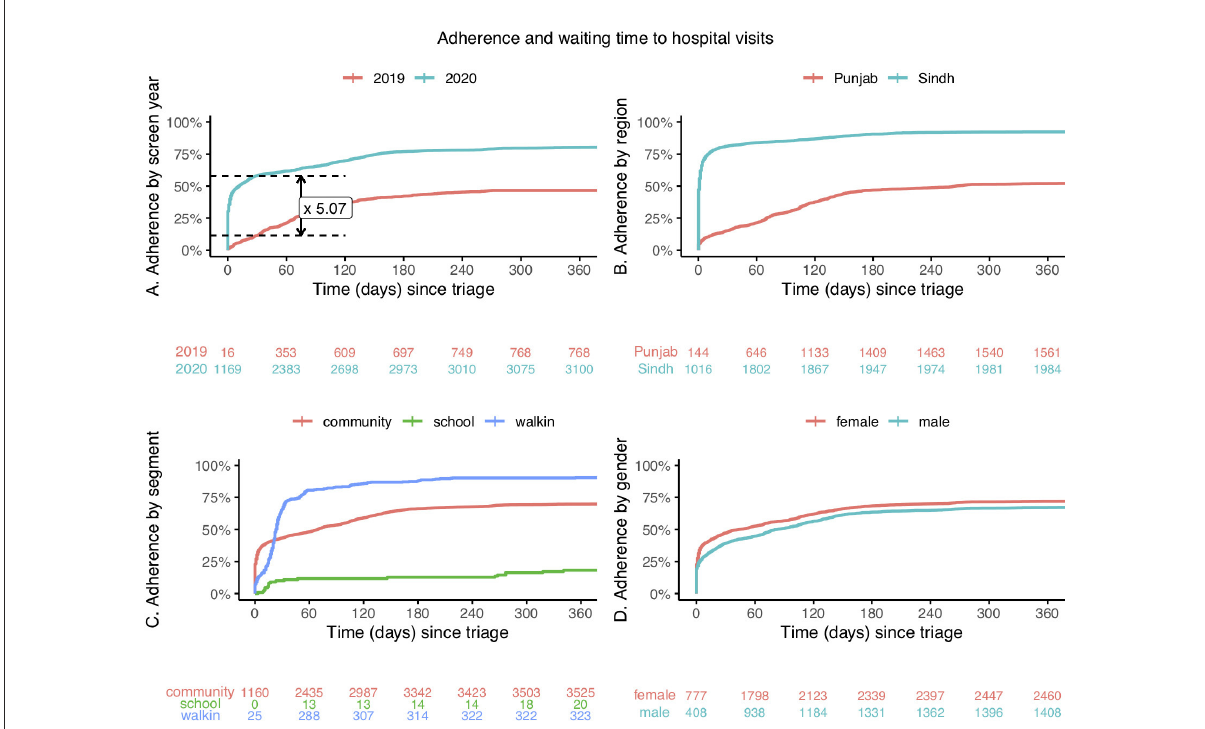
FIGURE4 Sub-group analysis of cumulative adherence to hospital referral, and waiting time to hospital visit, in 2019 and 2020. (A) By screening year. (B) By region. (C) By source of referral: community screening, school screening, unscreened walk-in patients. (D) By gender Red, blue and green numbers below the graphs represent the cumulative number of attendees to hospital eye services following referral from triage.